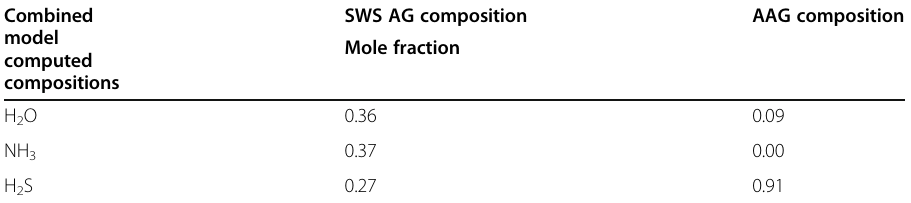
Table 14 Computed SWS AG and AAG mole fraction from the combined model Combined model